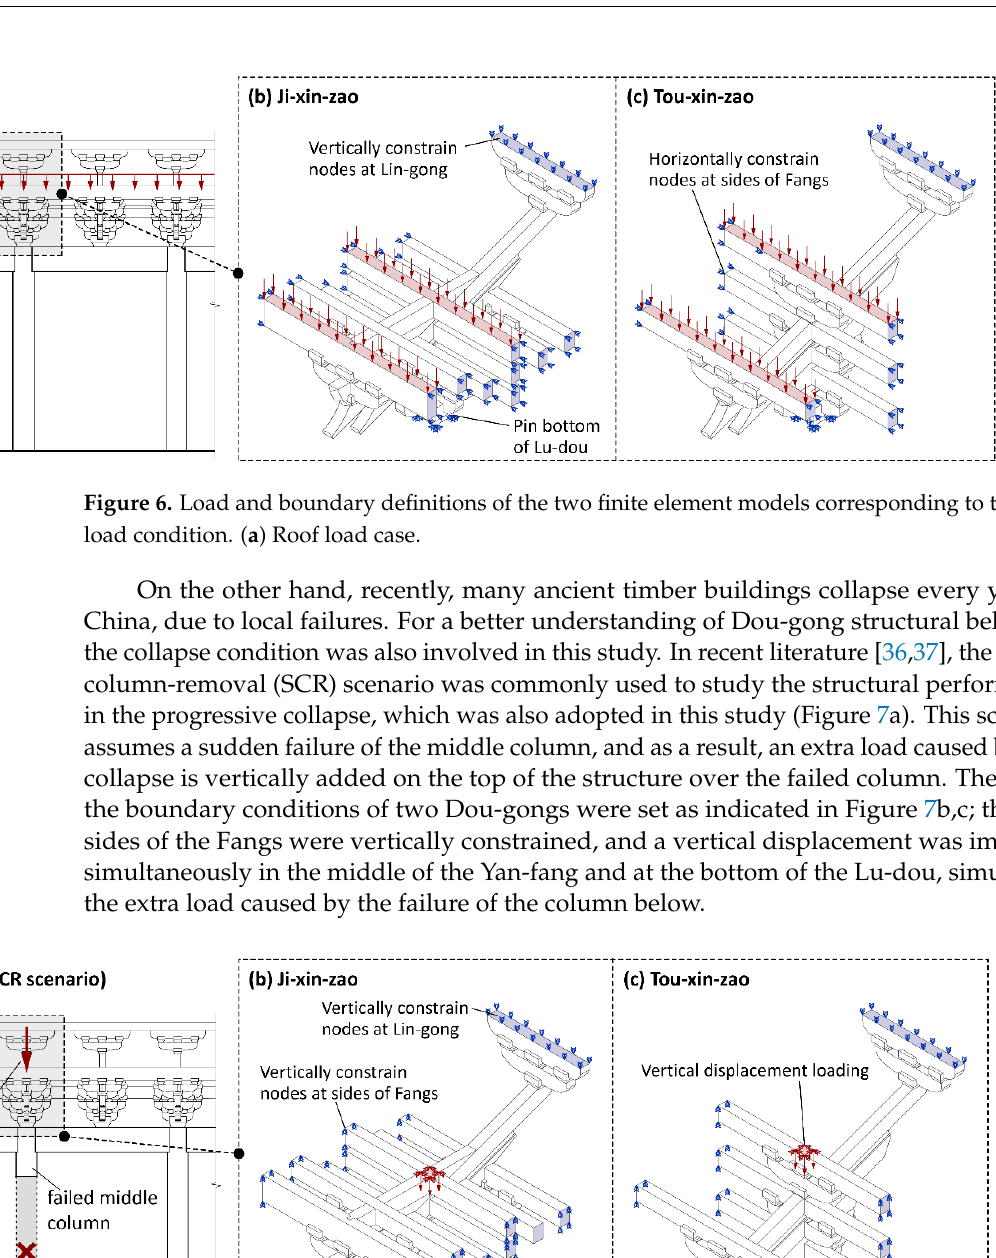
Figure 7. Load and boundary definitions of the two finite element models in the collapse condi- tion. ( a ) Collaspe case (SCR scenario); ( b ) Ji-xin-zao; ( c )